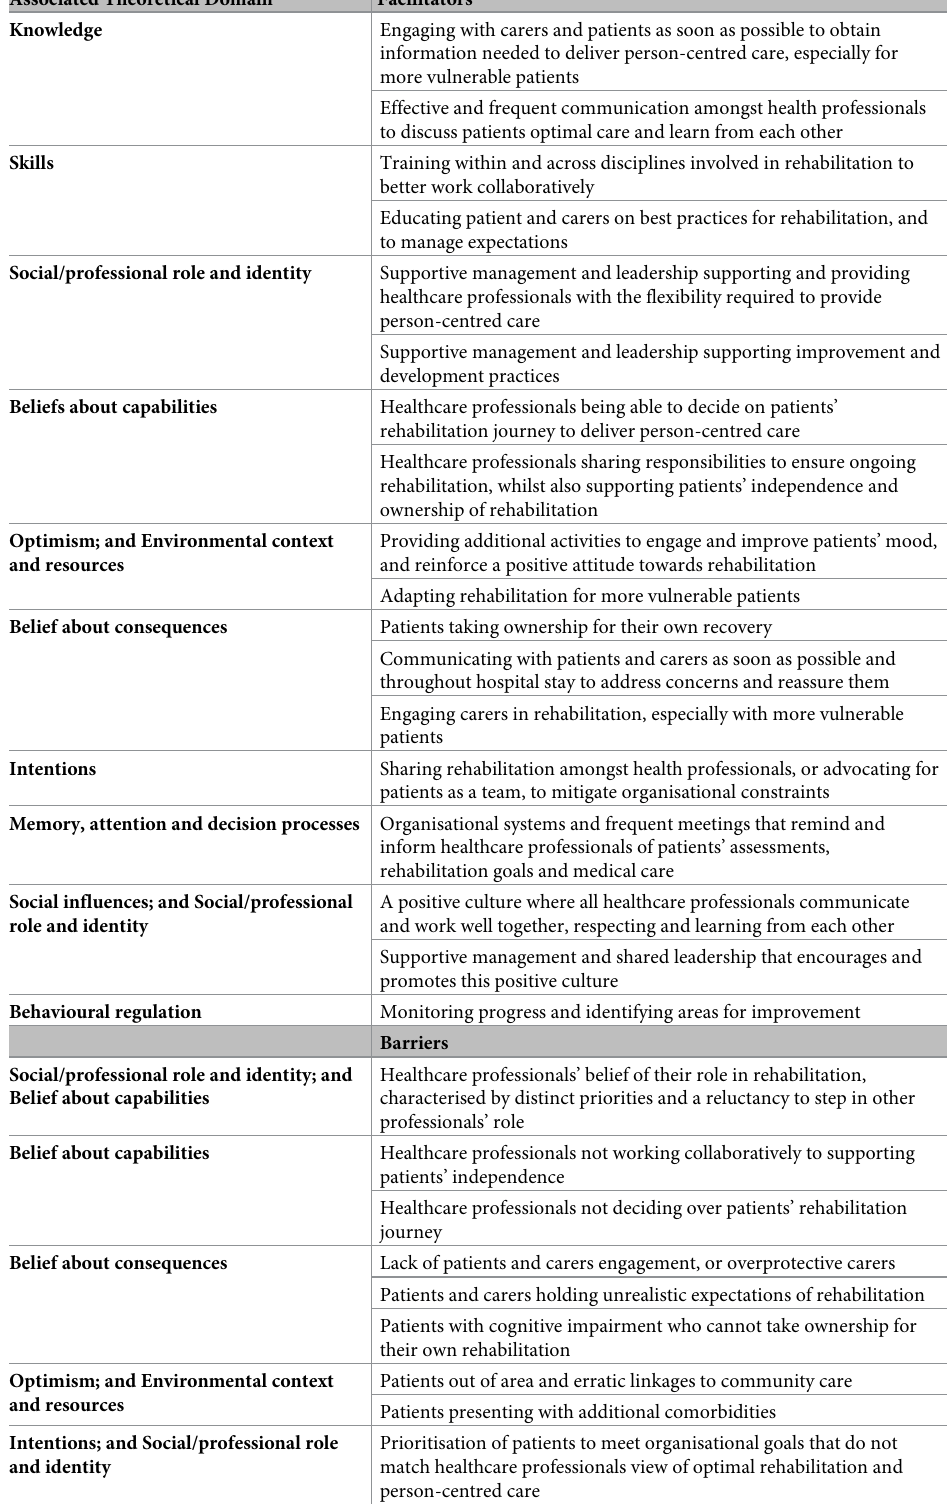
Table 3. Summary of multidisciplinary team perceived barriers and facilitators to acute rehabilitation service delivery after hip fracture according to domains of the Theoretical Domains